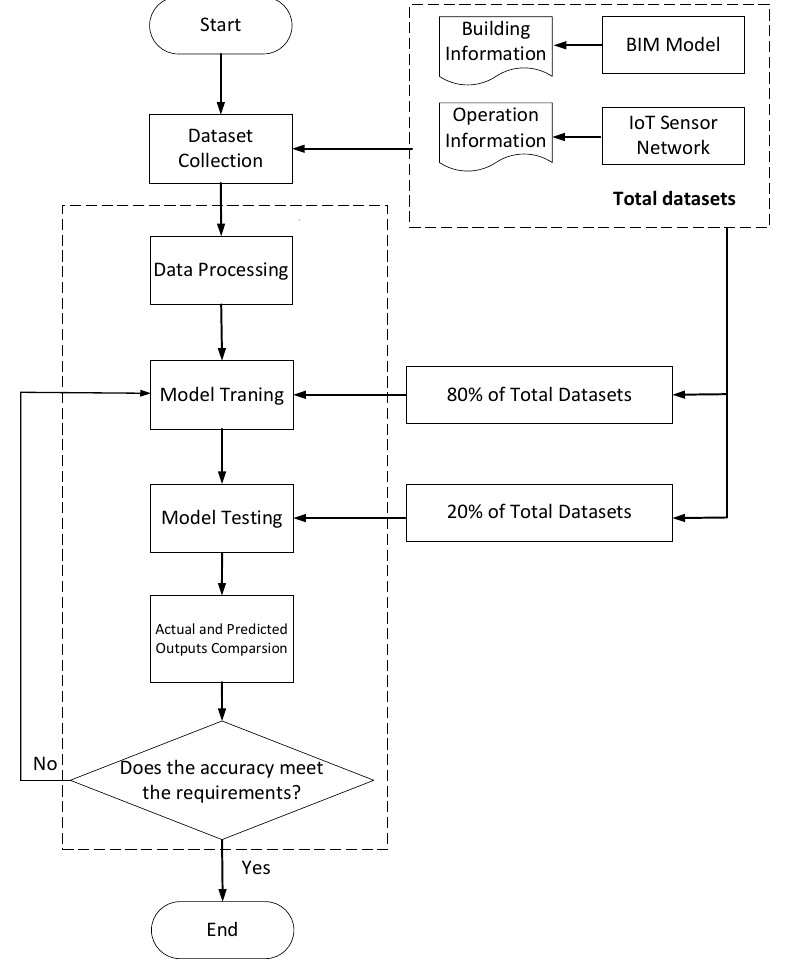
Figure 10. SVM prediction process.